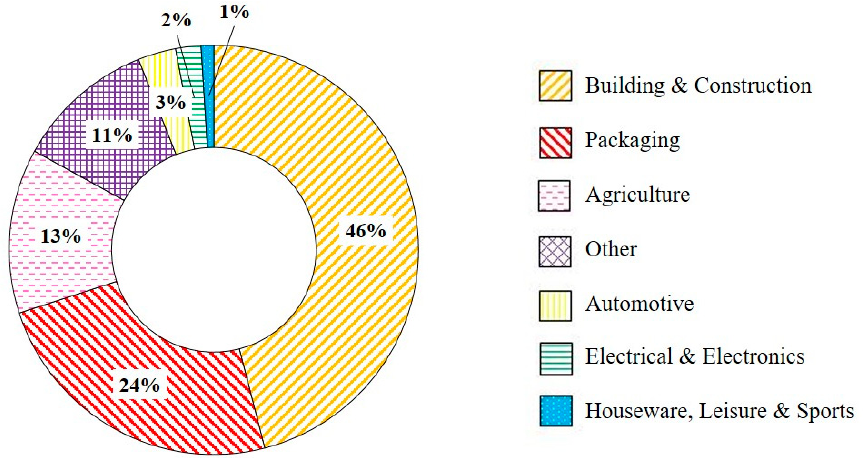
Figure 12. Use of post-consumer recyclates in different industries in 2019 [30].